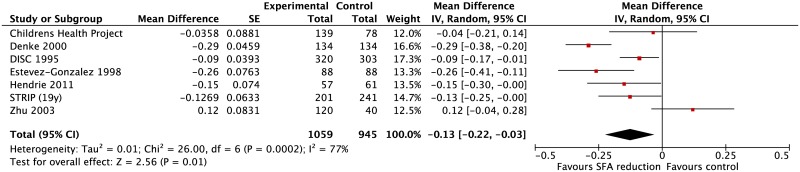
Meta-analysis of weighted mean (95% CI) differences in effects on LDL cholesterol (mmol/l) in randomised trials that compared usual diets with reduced saturated fat diets in children.